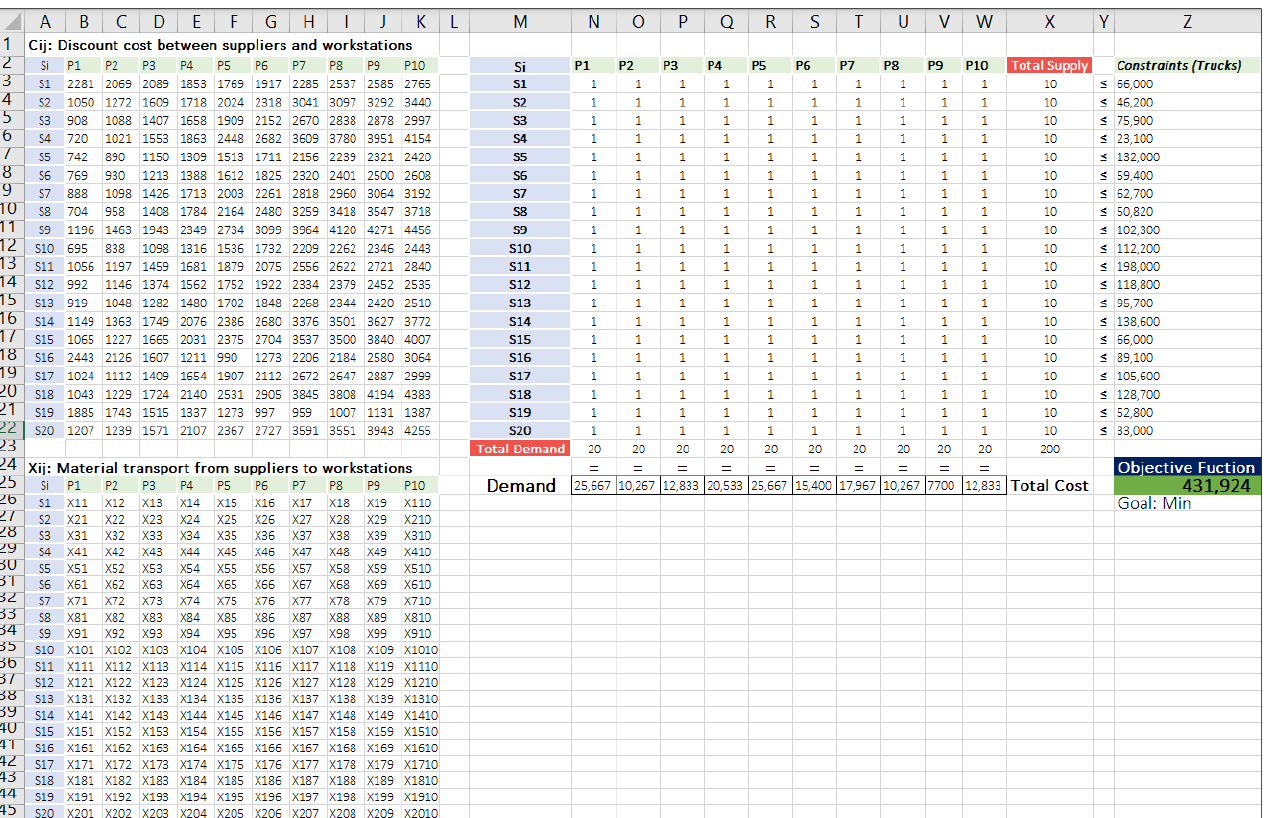
Figure 6. Material logistics data fed automatically to MS Excel Solver.